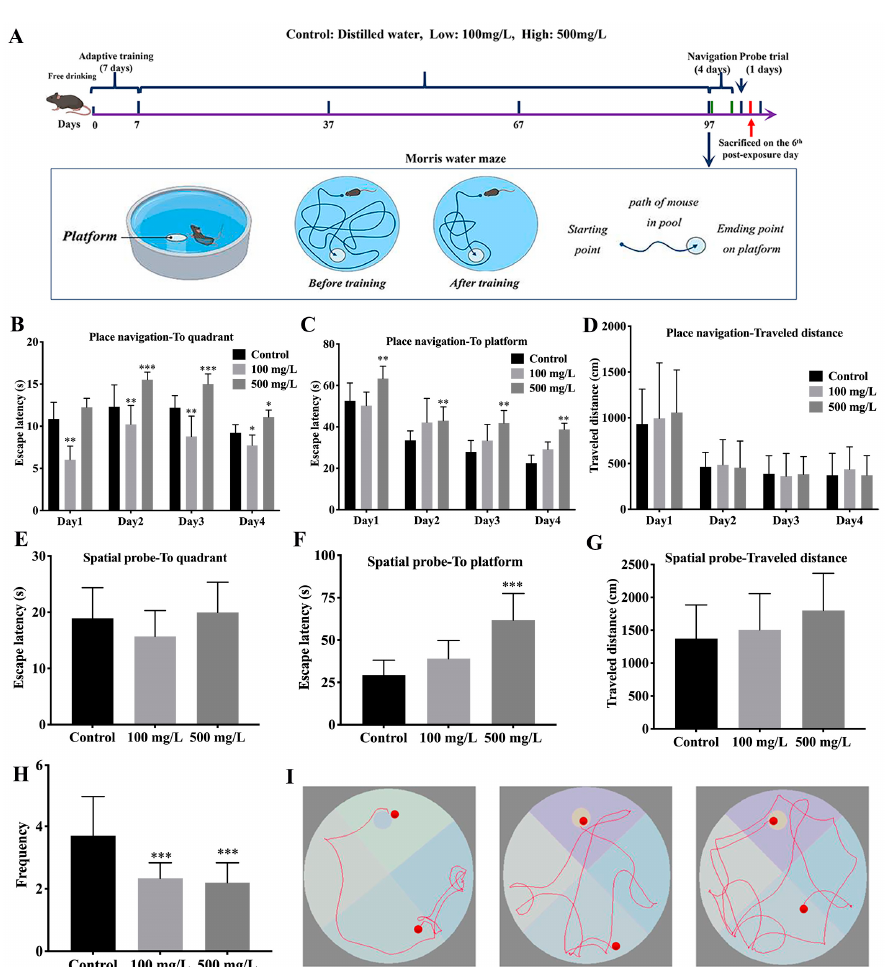
Figure 1. Cu impairs learning and memory in mice. ( A ) Schematic of study protocol timeline. After one-week acclimatization, the mice were induced for 90 consecutive days. After 97 days, MWM tests were performed. Towards the end of the tests, the mice were sacrificed by anaesthetization. MWM: Morris water maze, total N = 10 × 3 = 30. ( B ) Escape latency in the target quadrant. ( C ) Escape latency in the target platform. ( D ) Travel distance in the spatial training. ( E ) The latency of target quadrant in the probe trial. ( F ) The latency of target platform in the probe trial. ( G ) Travel distance in the probe trial. ( H ) The crossing-platform times in the probe trial. ( I ) Representative tracking paths of mouse in MWM. (* p < 0.05, ** p < 0.01, *** p < 0.001).